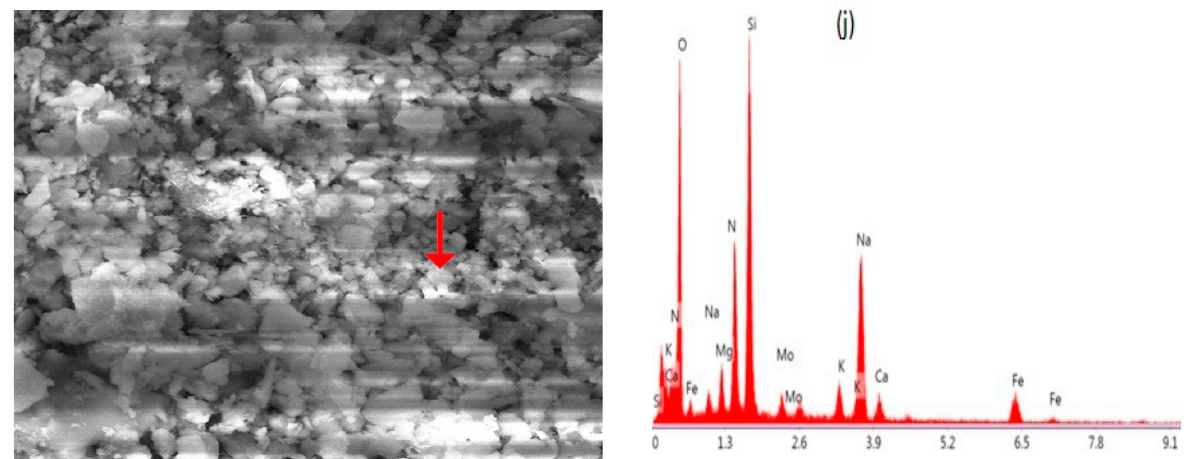
Figure 6. ( a ) Carbonaceous particle, agglomerated shape with a size of 0.54 µ m. ( b ) Sulfur-rich particle, size range from 2.1 µ m to 7.3 µ m. ( c ) Biogenic particle, length of 0.86 µ m and 0.3 µ m in width. ( d ) Na–Feldspar, sharp edged-shape, with average size of 2.4 µ m. ( e ) Ca–Mg aluminum silicate, irregular shape. ( f ) K-feldspar (K aluminum silicate), irregular shape. ( g ) Grossular, irregular shape, size range from 0.23 to 0.45 µ m. ( h ) Biotite, irregular shape. ( i ) Almandine, irregular shape. ( j ) Nitrate-rich particle, with a size of 0.29 µ m.